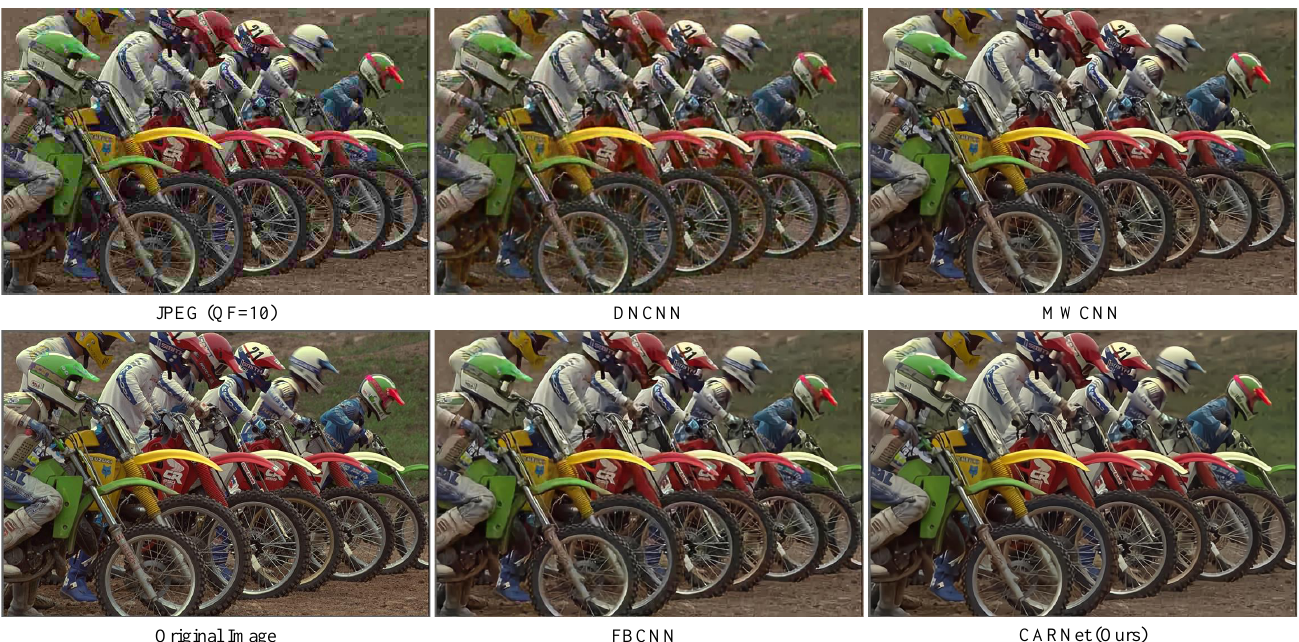
Figure 13. Visual comparison with state-of-the-art methods on a color JPEG image from the LIVE1 dataset.